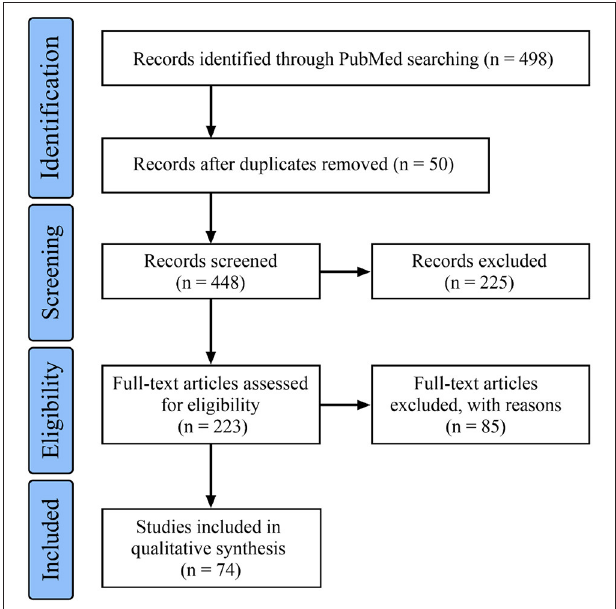
FIGURE 1 | Flowchart of the search